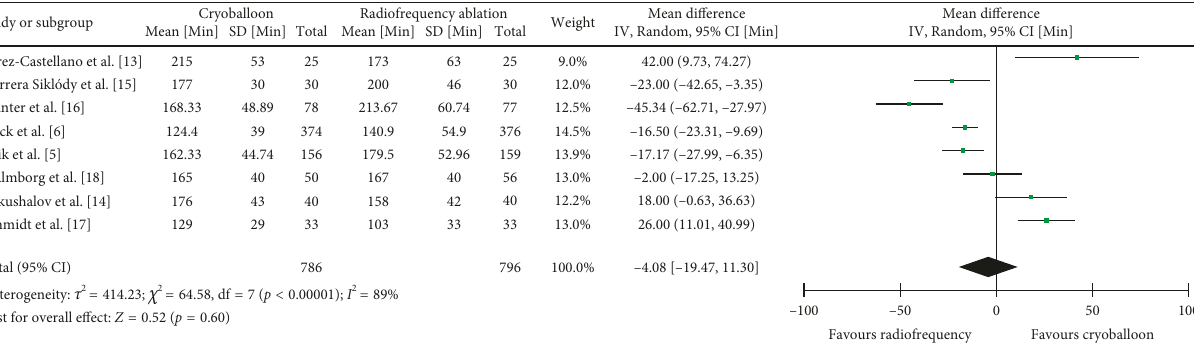
12-month follow-up. ≥